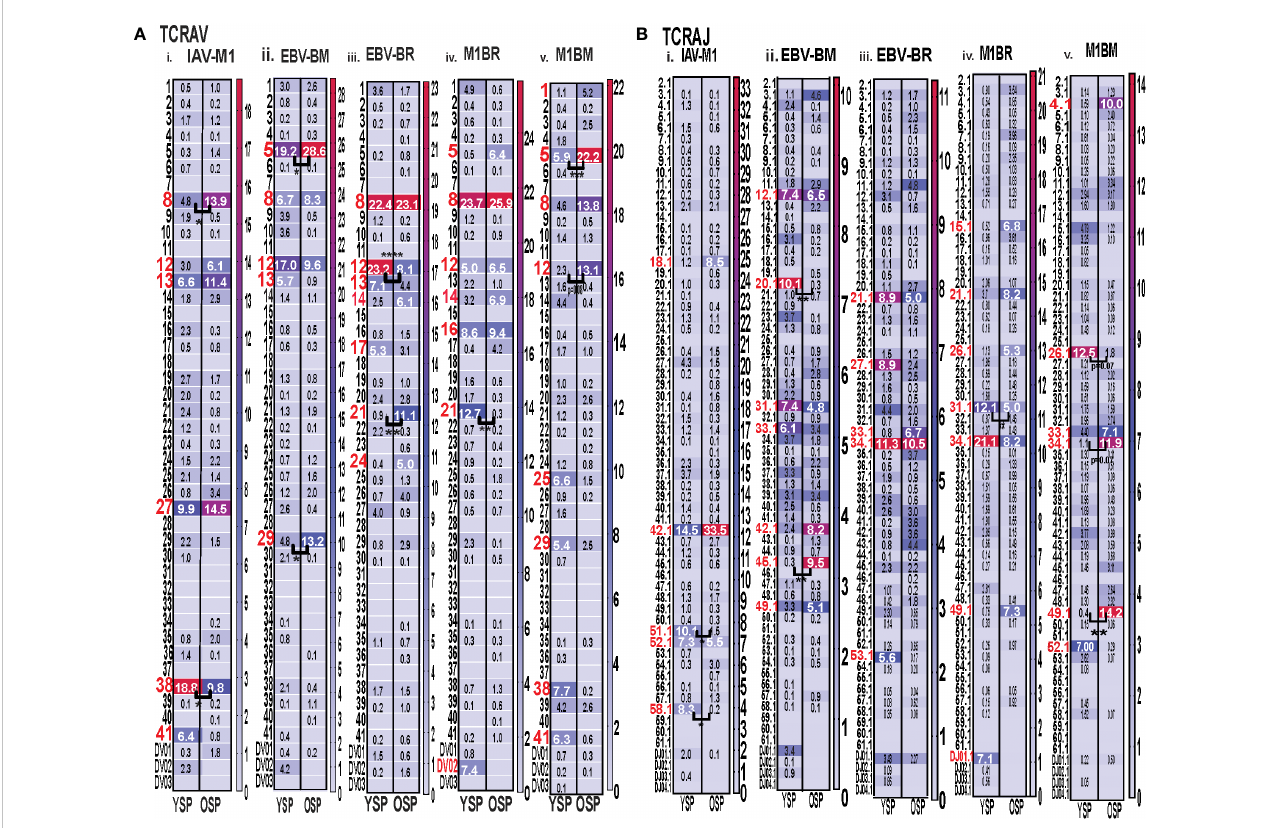
FIGURE 4 Signi fi cant differences in TRAV and AJ family usage in IAV and EBV-speci fi c and cross-reactive responses between young (Y) and older (O) donors. TRAV and AJ families determined for IAV-M1, EBV-BM, and EBV-BR cognate and cross-reactive responses in short-term cultured CD8 T cells that were tetramer-sorted and sequenced (Y n=4, O n=4-5). M1BM or M1BR are cross-reactive EBV-BM or EBV-BR single tetramer+ cells sorted from IAV-M1 stimulated short term cultures. (A) Heatmap analyses of TRAV (A) and AJ (B) family usage, showed signi fi cant differences in epitope-speci fi c responses between Y and O. Multi-variant 2-way ANOVA with adjusted p-value, *p < 0.05, **p < 0.01, ***p < 0.001, ****p < 0.0001. (Also see Supplemental Table S3 for statistical